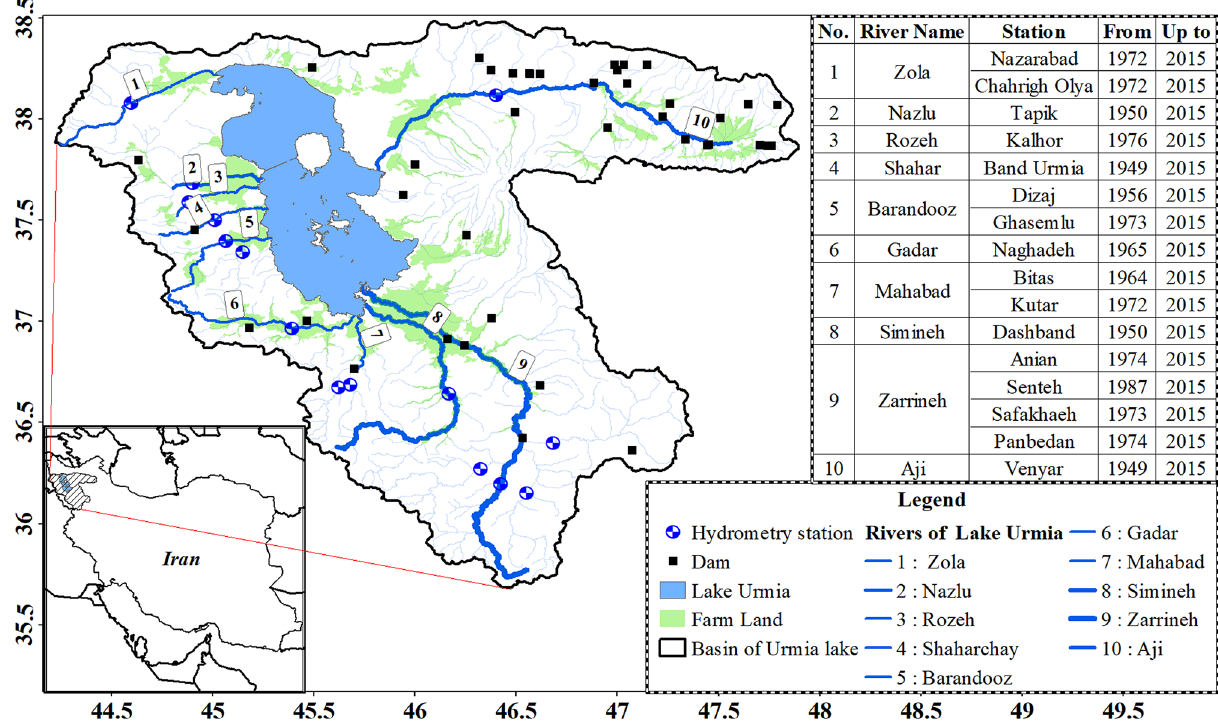
Figure 1. An overview of the Urmia Lake basin, the rivers, and selected gauging stations. Figure 1 was generated by ArcGIS v10.2 software 50 (Environmental Systems Research Institute, Inc., USA, URL http:// www. esri.